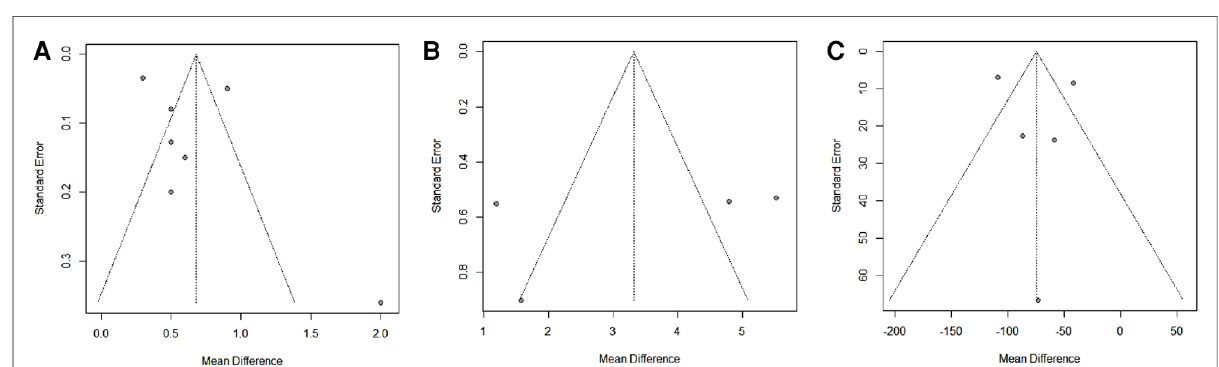
FIGURE 7 The funnel plots for the size of grafts ( A ), anteroposterior translation of humeral head ( B ), and deltoid force ( C